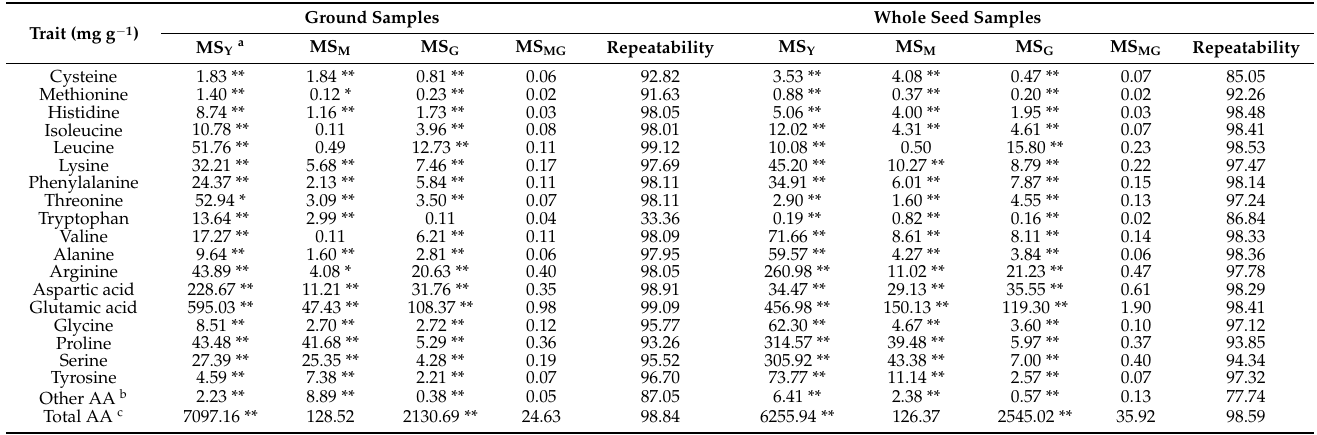
Table 3. Mean squares from ANOVA and repeatability estimates (%) of seed amino acid contents in edamame with ground and whole seed samples by the combined data of freeze, low-heat and high-heat drying